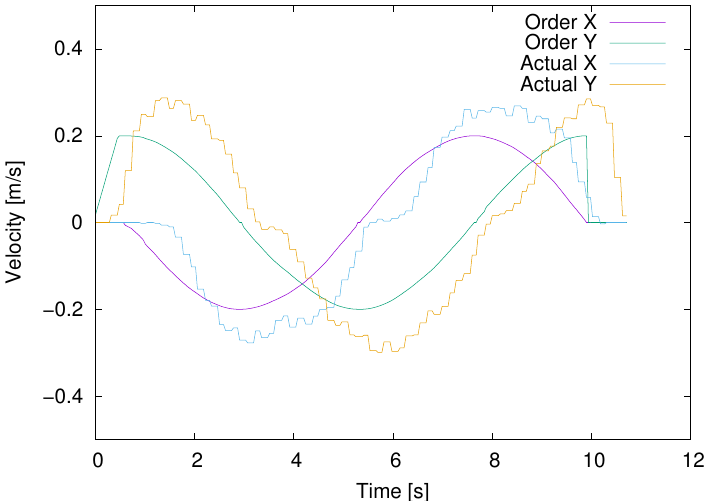
Figure 7. Transition velocities of one of our experiments (circle pattern, proposed configuration, experiment no. 1). Table 2. Median and interquartile range (IQR) of the distance error—circle pattern. Distance Error [m]